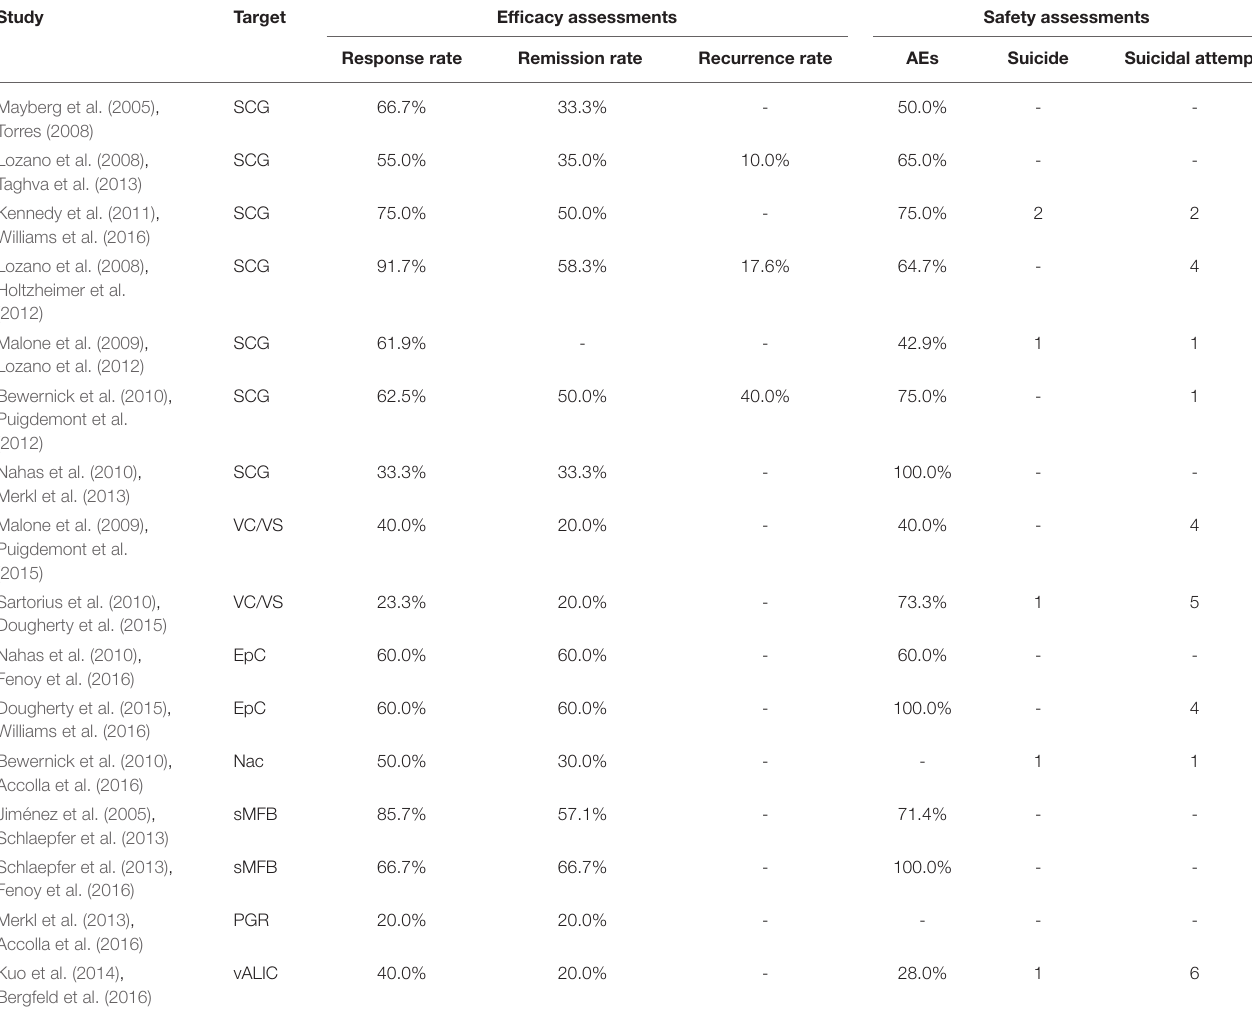
TABLE 2 | Summary of the efficacy and safety assessments (open-label studies).